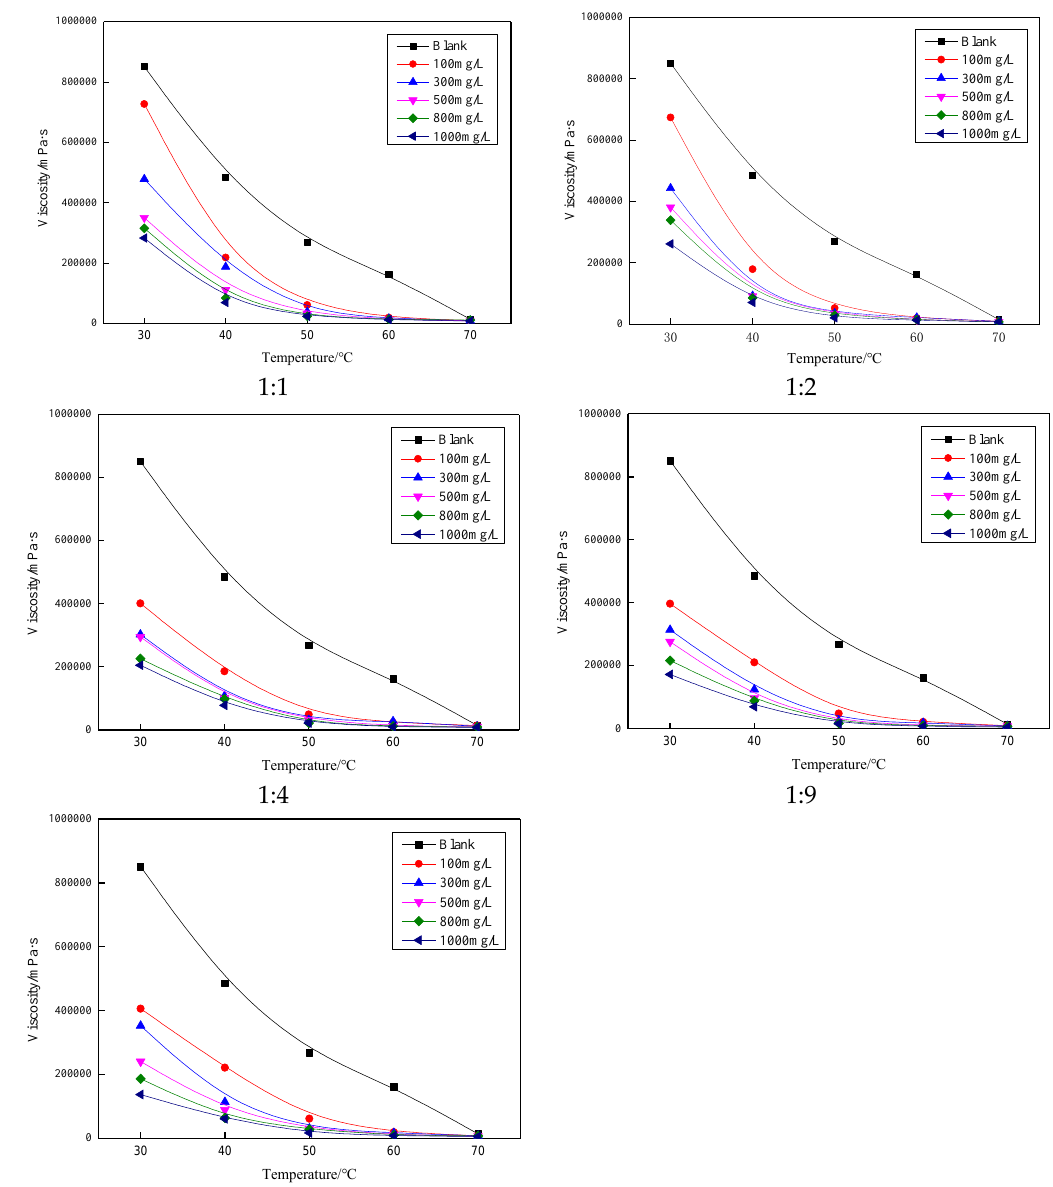
Figure 6. Effect of concentration on viscosity of oil samples at different volume ratios of modified polystyrene to diesel.